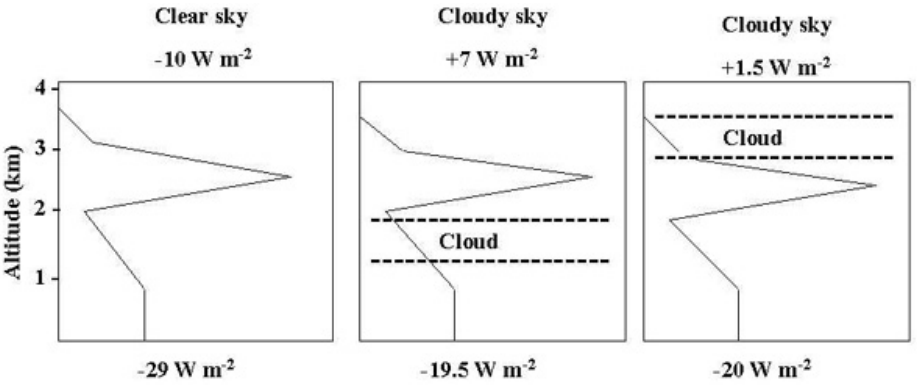
Fig. 3. Effect of cloud reflection on the aerosol radiative forcing. The dotted line represents the cloud layer and the solid line shows a vertical profile of aerosol concentration. The details of cloud properties used are given in the